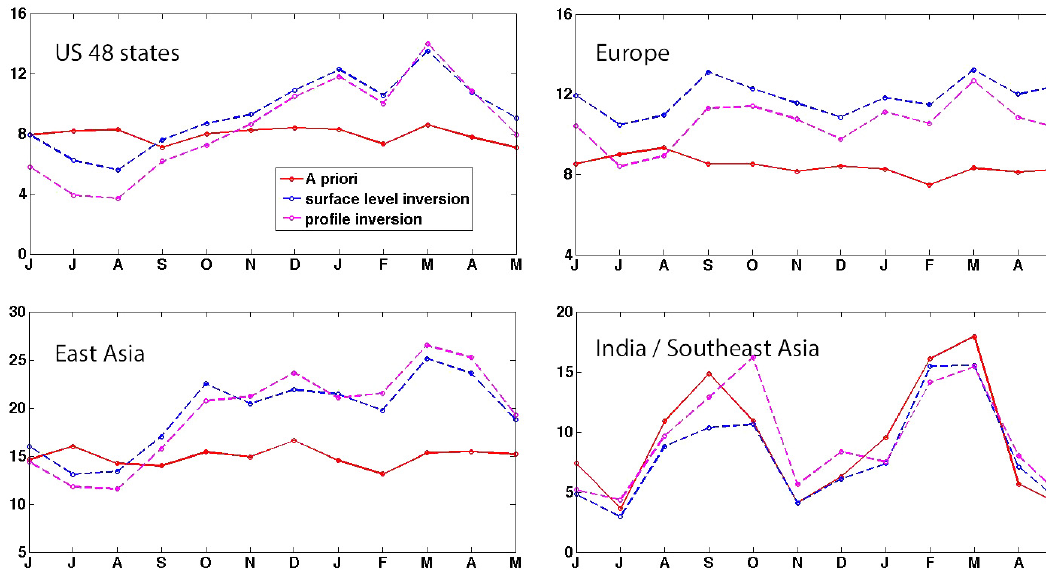
Figure 3. Monthly variation of regional combustion CO emission